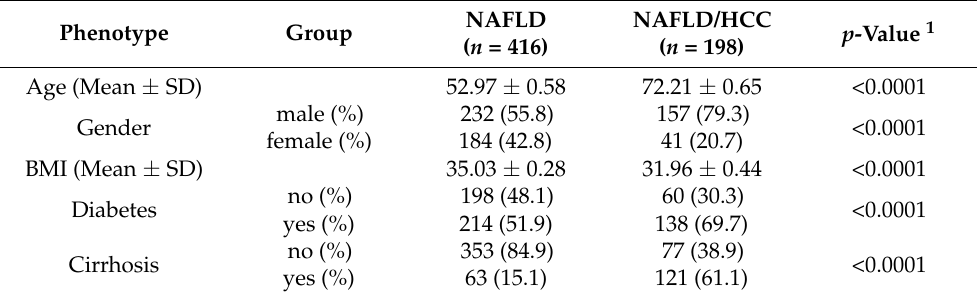
Table 1. Demographic characteristics of Newcastle NAFLD and NAFLD-HCC